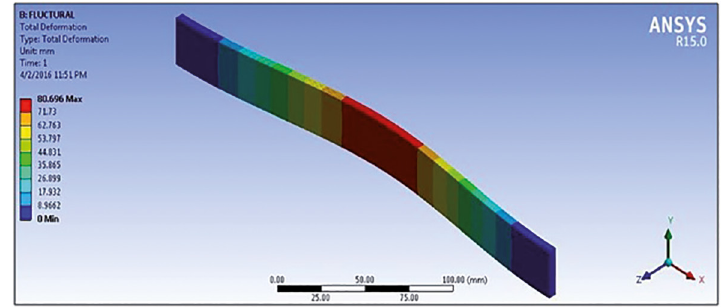
Figure 14: Typical deformation plot during flexural loading